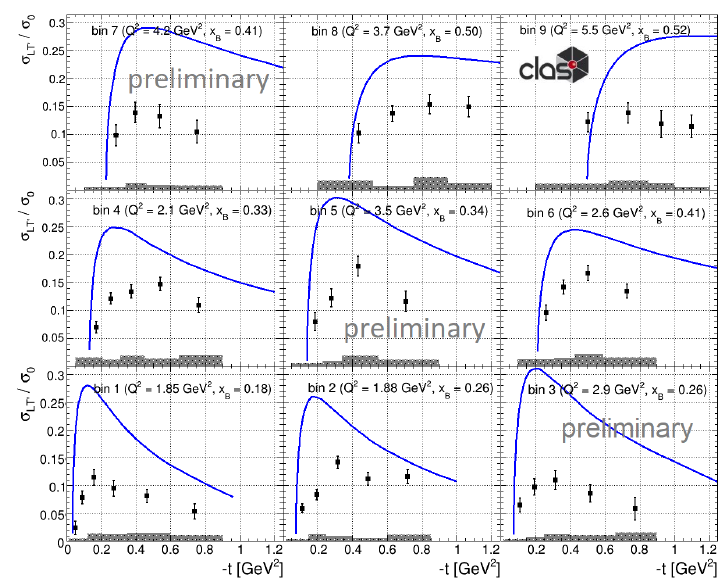
/σ Figure 4: σ as function of − t for different Q 2 − x LT (cid:48) 0 scheme shown in Fig. 3. The gray histogram shows a preliminary estimate of the systematic uncertainty. The blue line shows the predictions from the GK model [ 17 ] at the stated mean value of the bins